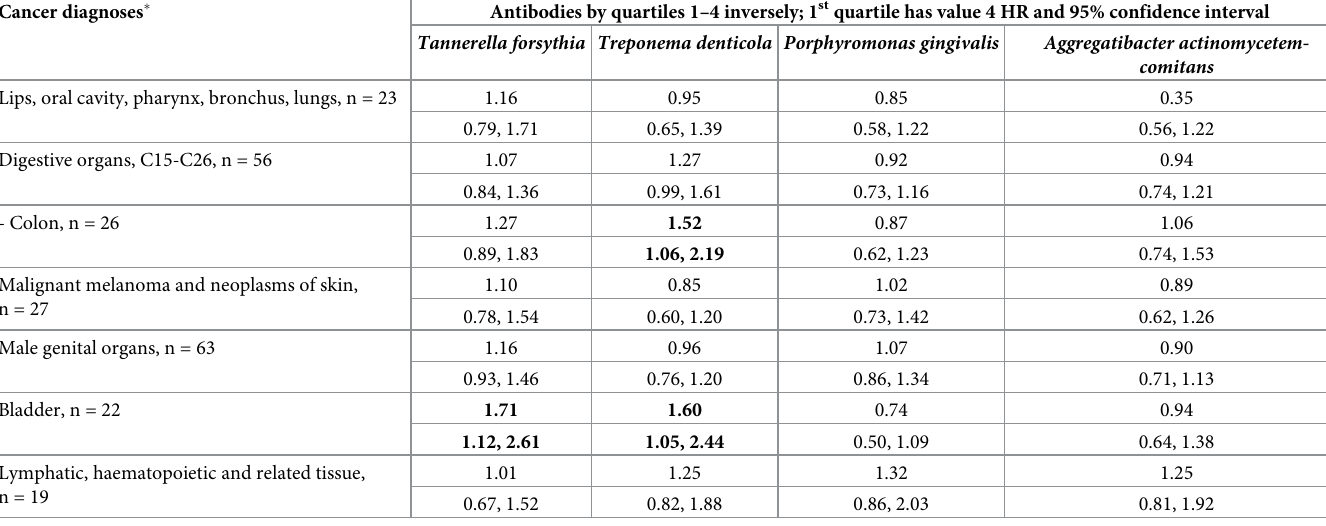
Table 3. Age, daily smoking and years of education adjusted multivariate Cox proportional regression analyses of antibodies to four oral bacteria on cancer incidence. Cancer diagnoses